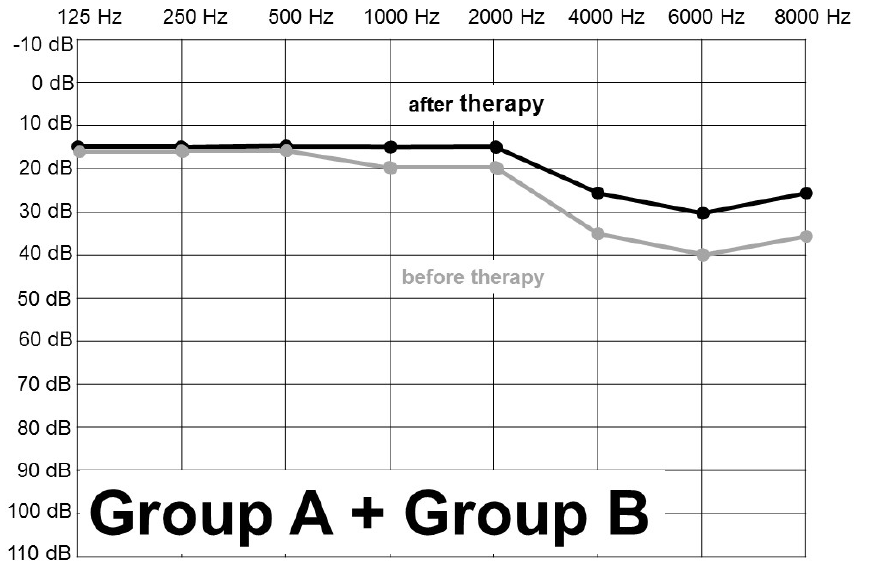
Figure 3. PTA before and after the treatment of AAT—in total in all AAT (n = 141 ears).